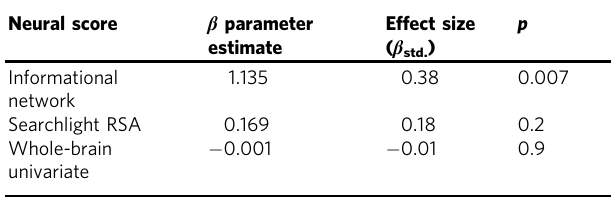
Table. 1 Qualitative differences between neural score Table. 2 Regression results for neural scores